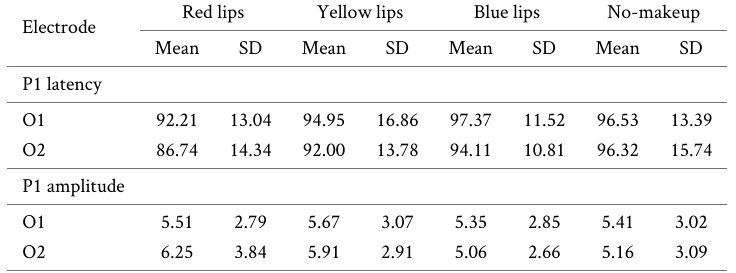
Table 2. Mean P1 latency (ms) and amplitude ( µ V) for all conditions at two electrode sites.